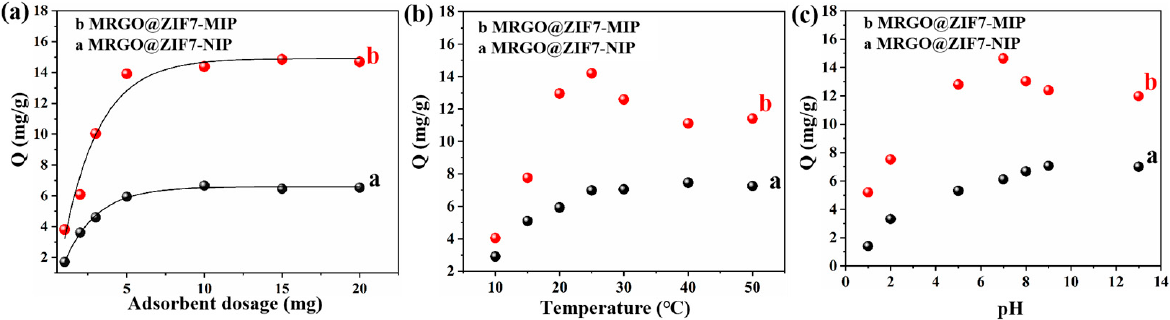
Figure 5. Adsorption effect of different factors : adsorbent dosage ( a ), temperature ( b ), pH ( c ). Other conditions: 10 mL sample solution of 0.08 mmol L − 1 BPA.